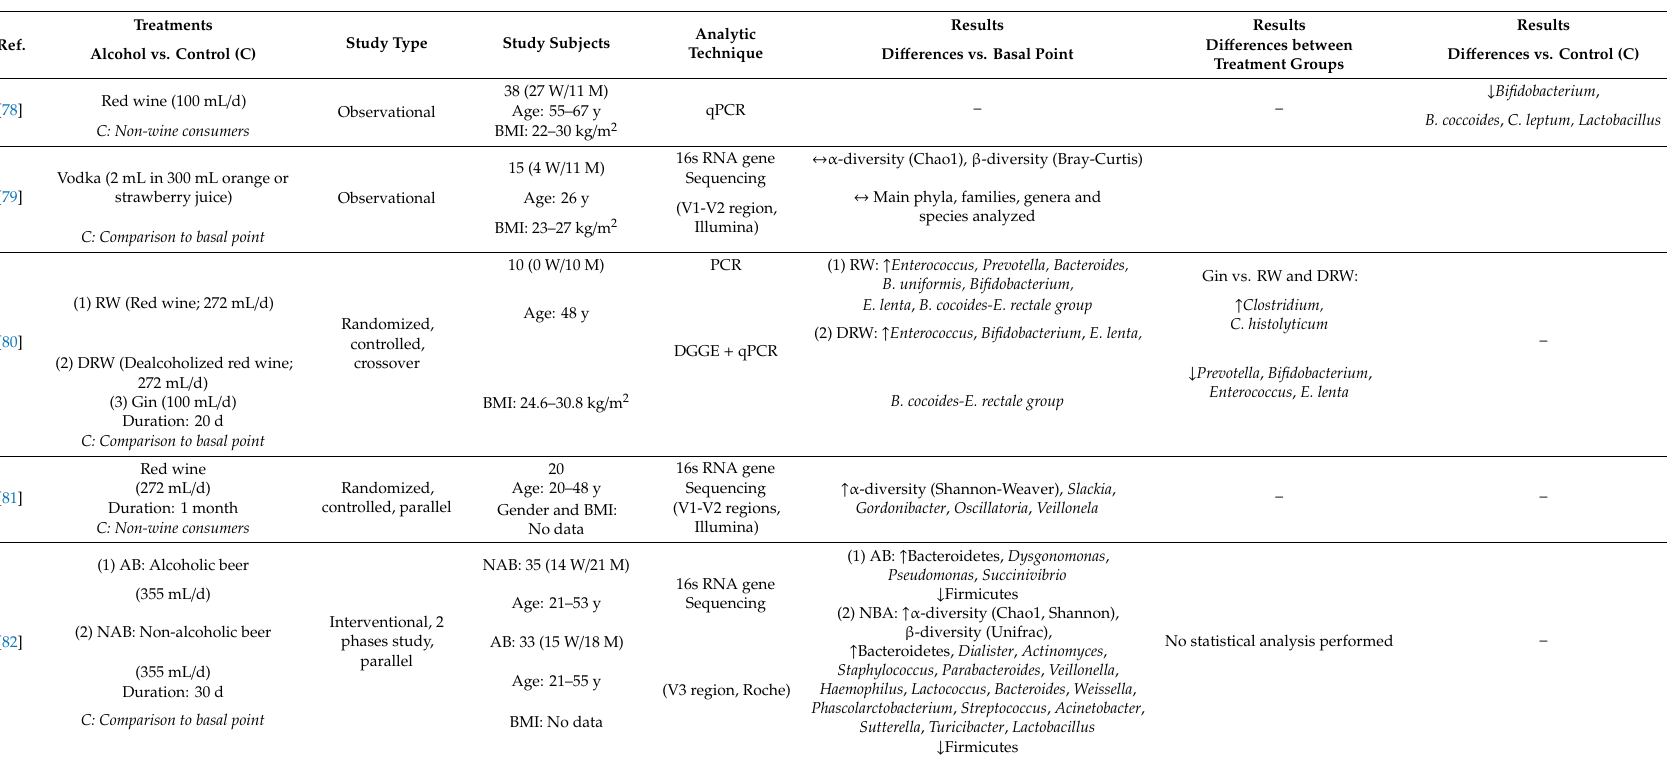
Table 3. Evidence from human studies relative to alcoholic beverages e ff ects on the gut microbiota composition of healthy adults.